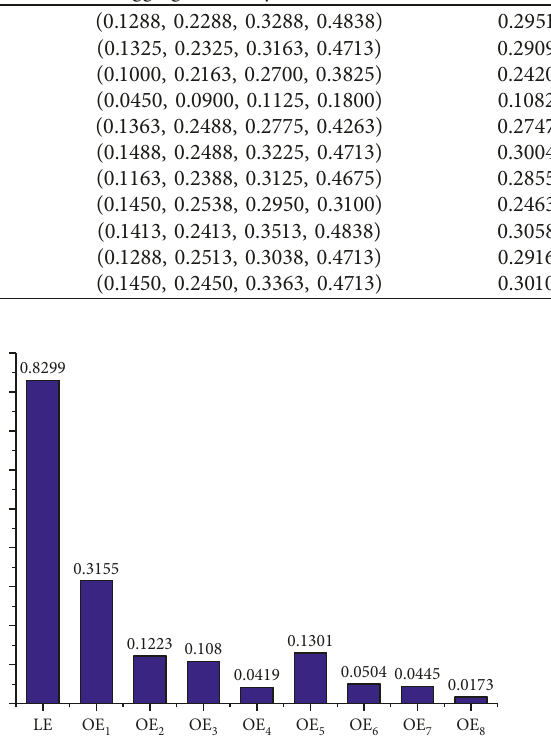
Table 14: Calculation of FPS, FFR, and the occurrence probability of environmental failure, operational error, and multiple failures. Event